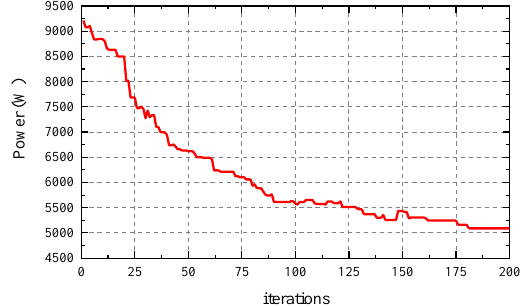
Figure 11. Evolution of HHR energy consumption with AMGA. Table 4. Optimization results.